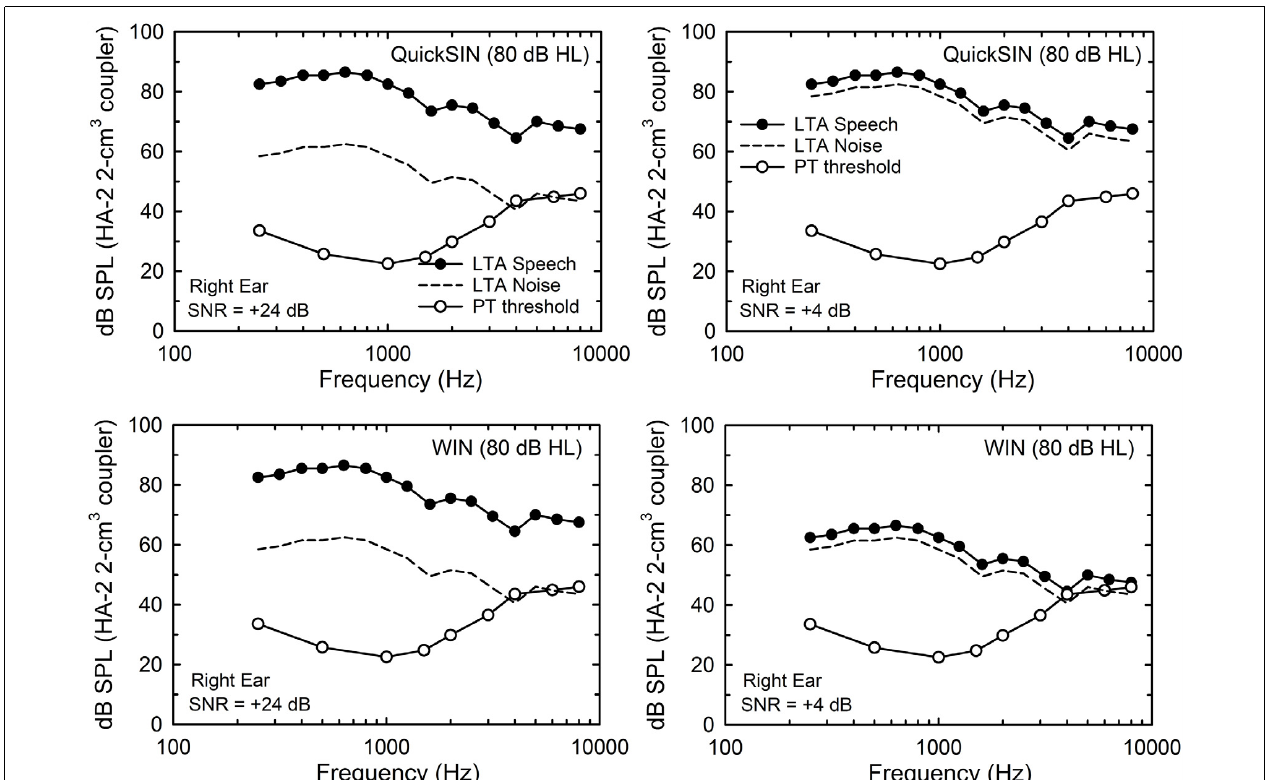
FIGURE 2 | The 1/3-octave-band levels for the long-term average (LTA) speech (filled circles) and competing noise (multi-talker babble; dashed lines) for the QuickSIN (top) and WIN (bottom) for the 80-dB HL (93-dB SPL) presentation condition. In the left two panels, the signal-to-noise ratio (SNR) is +24 dB (the maximum for the WIN and within 1 dB of the maximum for the QuickSIN) and in the right two panels, the SNR is +4 dB (near-threshold level for young normal-hearing adults). Also shown in each panel are the mean pure-tone thresholds for the 137 older adults in this study (unfilled circles).